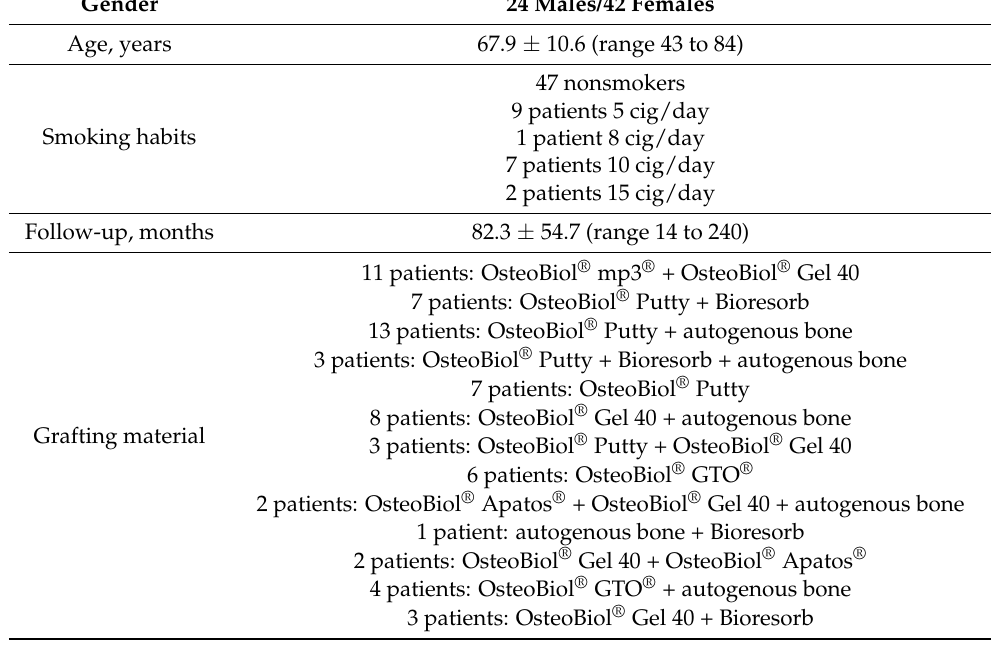
Table 1. Features of the patient sample and distribution of biomaterials used.